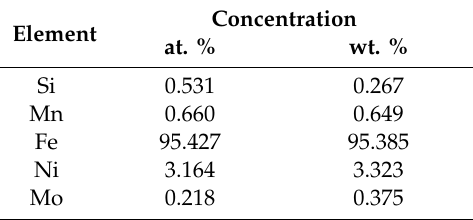
Table 10. The elemental composition of the tooth body (4—Figure 9). Concentration Element at. % wt.